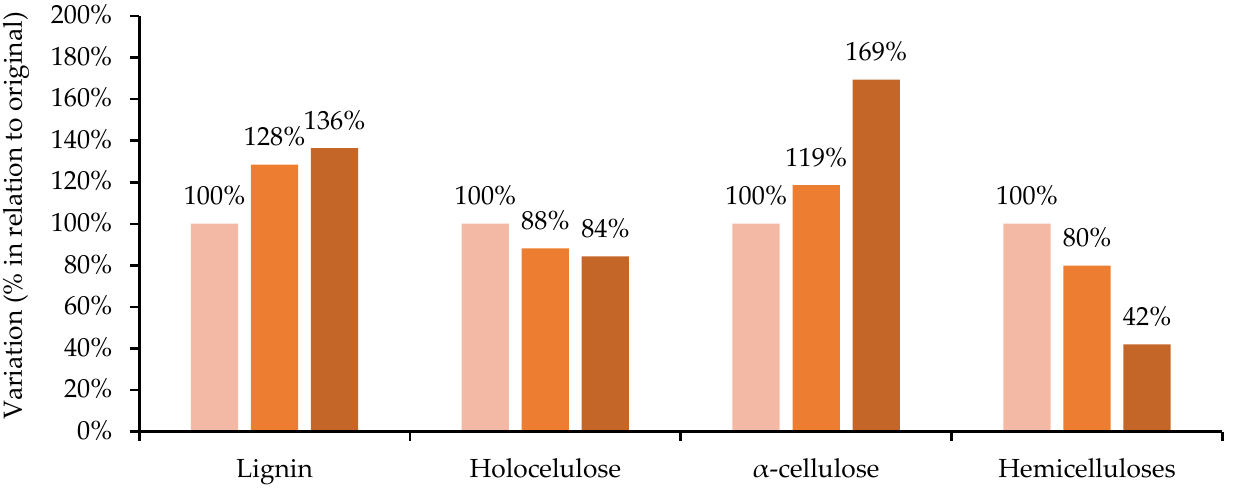
Figure 4. Variation in the chemical composition of the SCS hydrolysed in relation to the original sample, depending on the temperature at the end of the process (time of 180 min).